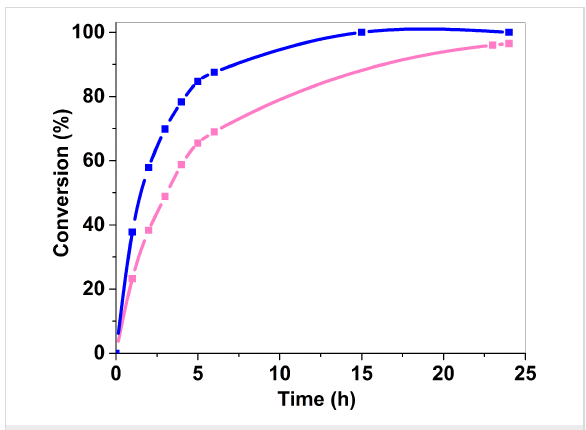
Figure 6: Monitoring over time of benzyl alcohol oxidative reaction with Au 25 (SG) 18 @ZrO 2 calcined at 300 °C for 4 hours under air (A 300 ) at 60 °C (pink), and at 80 °C (blue).